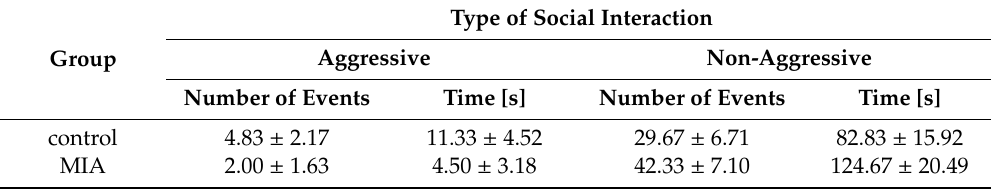
Table 1. The e ff ect of MIA on the social (aggressive and non-aggressive) behaviour of adult male Sprague-Dawley o ff spring, measured in the test of social interactions. n = 6 in each group. The results are presented as the means ± SEM.